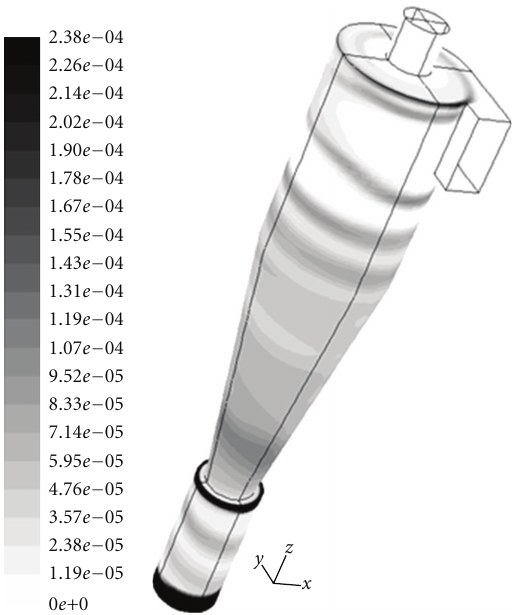
Figure 5: Contours of entropy generation for a pure-gas case (case PV2 in Table 2).